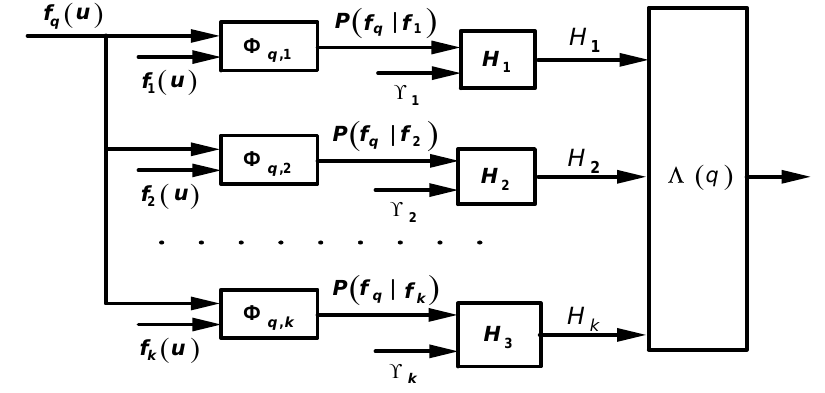
Fig. 1. Scheme of the decision rule work